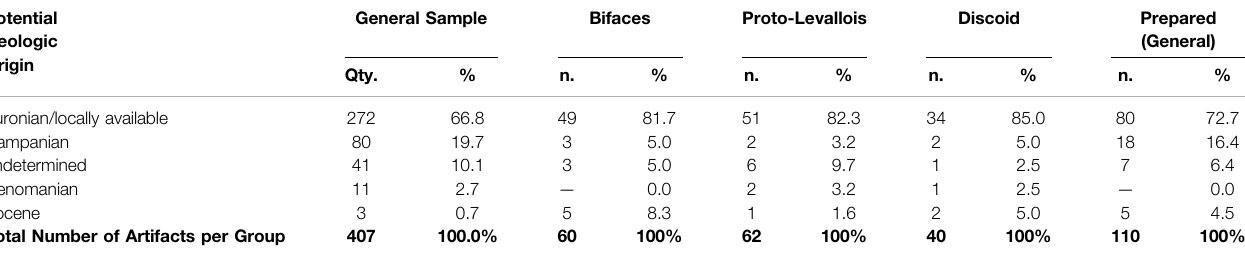
TABLE 5 | Potential geologic origins of the three Jaljulia samples. The Levallois, discoid and prepared core (general) groups include their products and CTEs. Potential